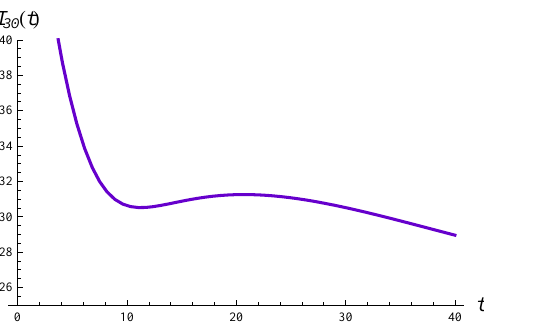
Figure 10. The intensity of losses vs. the time for the service time distribution F 2 .